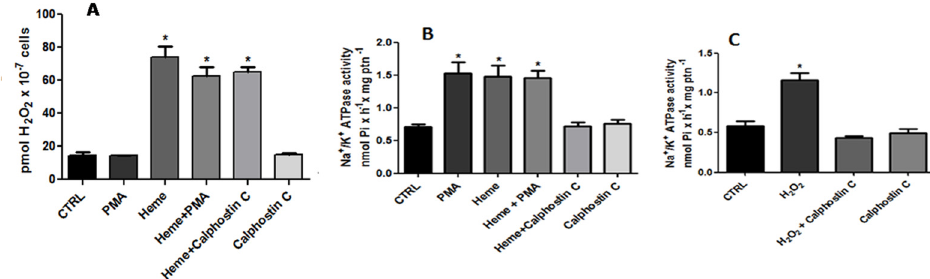
Fig 8. The involvement of PKC in the activation of Na + /K + ATPase by hydrogen peroxide generated through theme. Living parasites were incubated for 20 min in the reaction medium with the addition of 0.1 nM PMA or 10 nM calphostin C in the presence or absence of 2.5 μ M heme, as indicated on the abscissa. Hydrogen peroxide production (A) and Na + /K + ATPase activity (B) were determined. Intact cells were incubated with 10 nM calphostin C for 20 min, either with or without the addition of 0.1 μ M hydrogen peroxide, as indicated on the abscissa, for an additional 20 min. Na + /K + ATPase activity (C) was determined. The values represent the mean ± standard error of at least three independent experiments. * Statistically significant when compared to control (P < 0.05). CTRL, control.